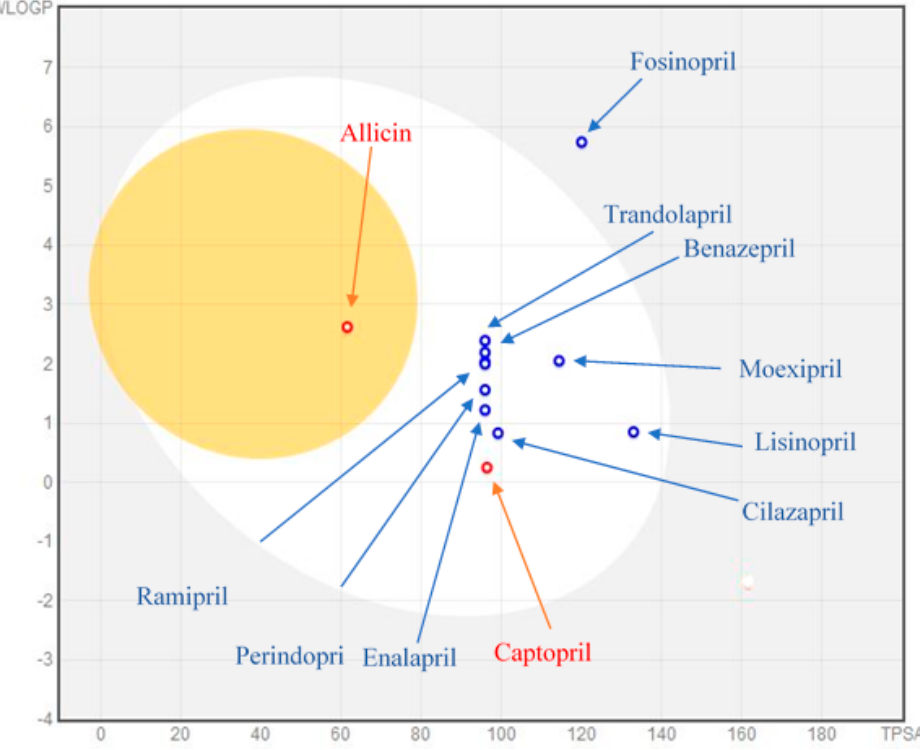
Figure 5. Evaluation of the analyzed ligands by the BOILED-Egg method.